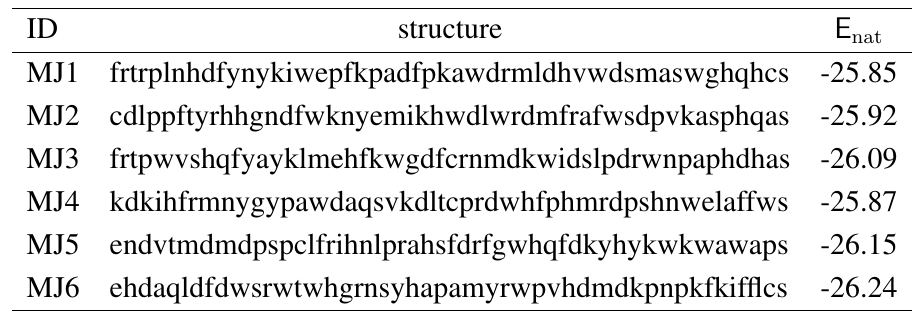
Table 2. Miyazawa–Jernigan (M-J) model benchmark problems (length 48) from [38], with minimum energy results for 3D cubic